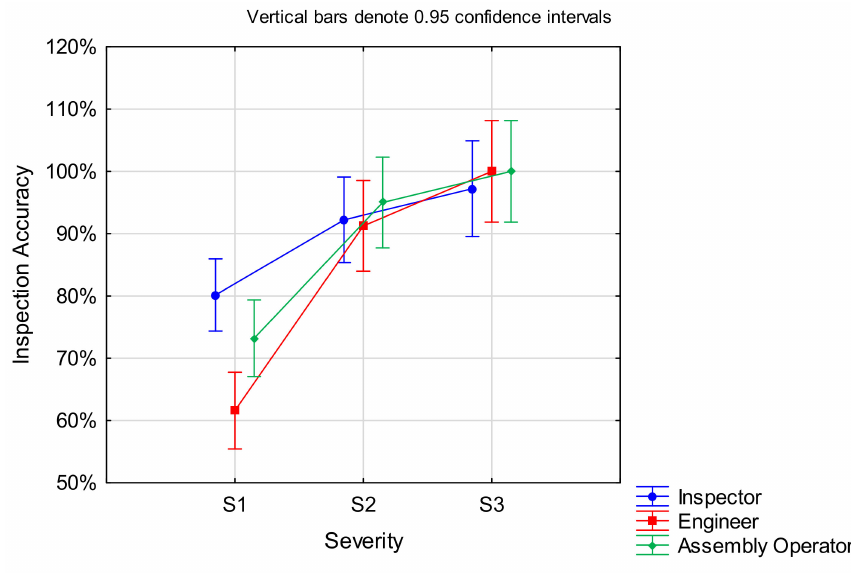
Figure 11. Effect of defect severity on inspection accuracy for each group of expertise.